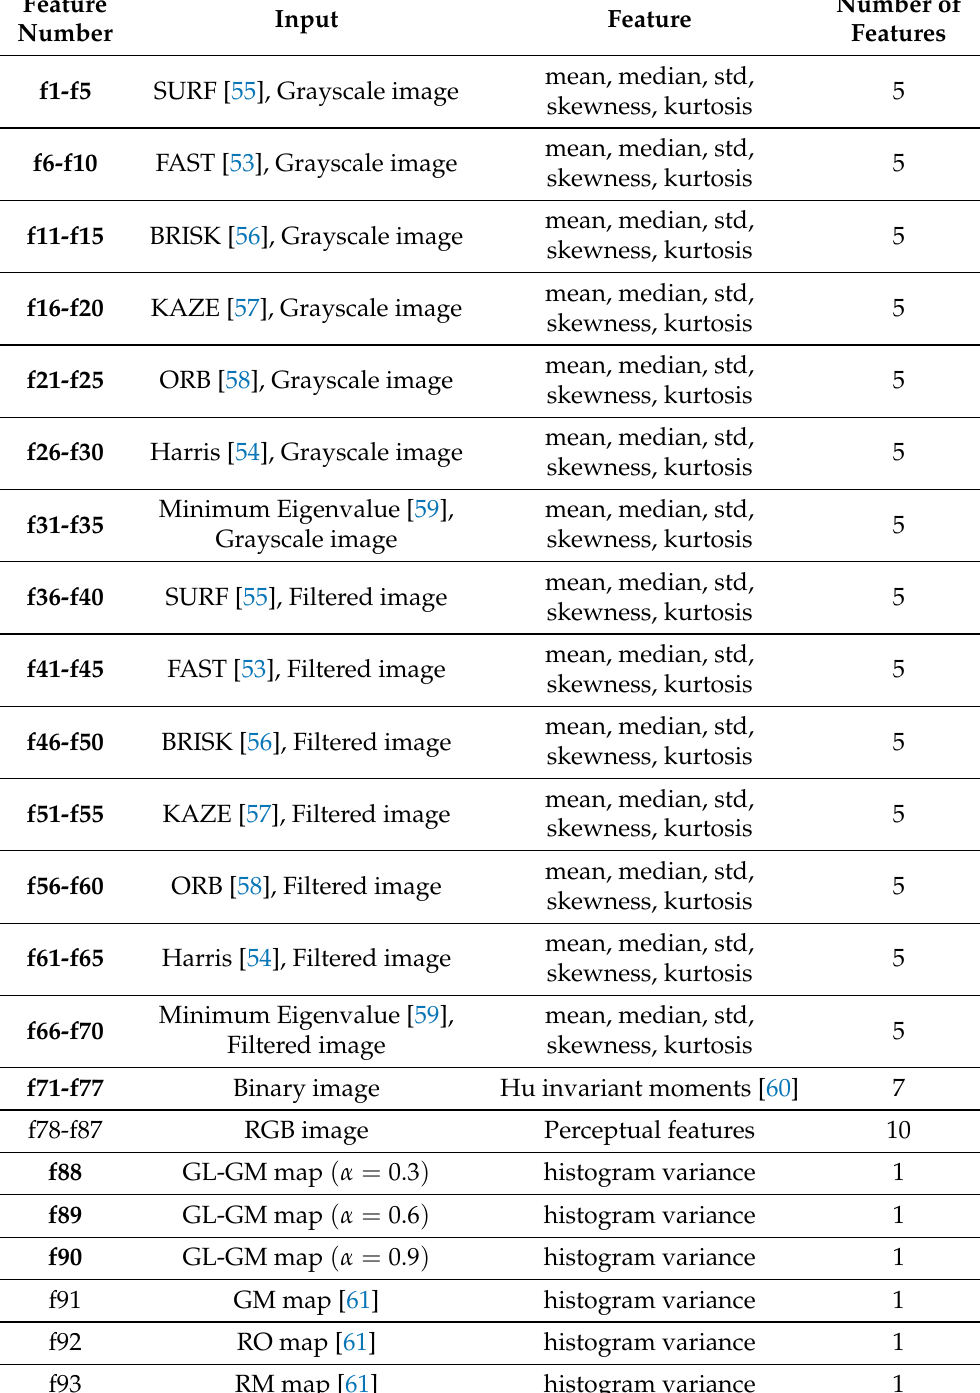
Table 3. Summary of the applied features. Quality-aware features proposed by this paper are in